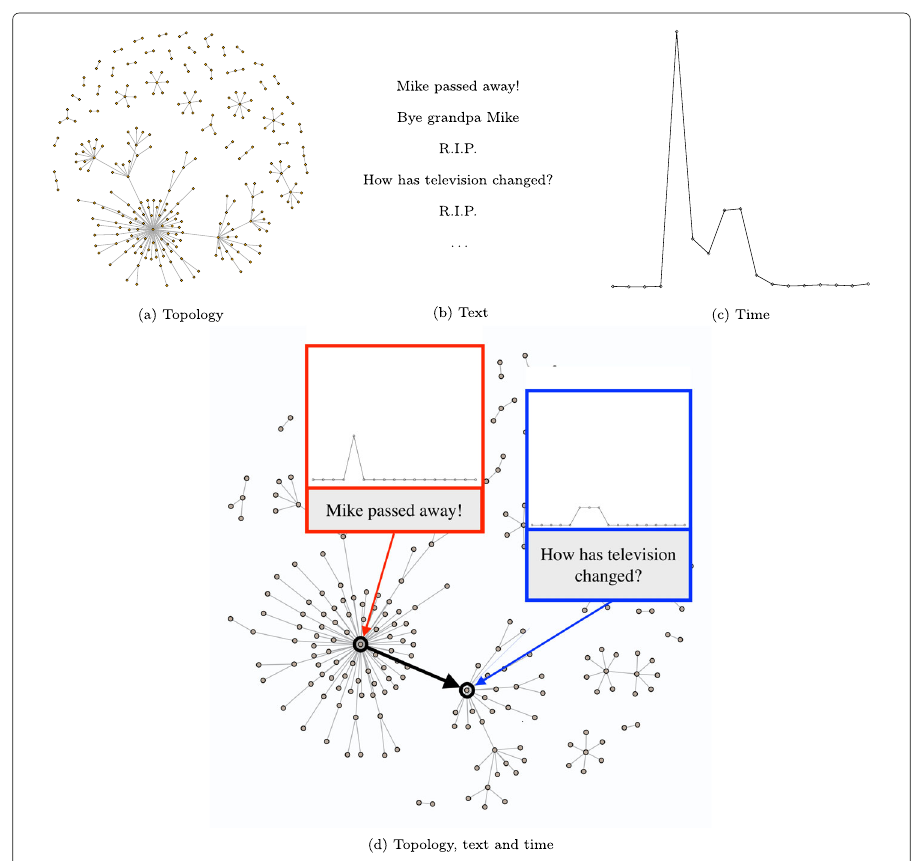
Fig. 1 Three elements of an online human information network: a ) The topology, where each edge represents an observed information propagation path: user A writes a post about some news, user B reads the post and writes herself about it, for example by commenting on it; b ) the text exchanged between users, that is, the text of posts and comments; c ) the number of comments over time; d ) Topology, time and text combined into a temporal text network. Only details about two posts are